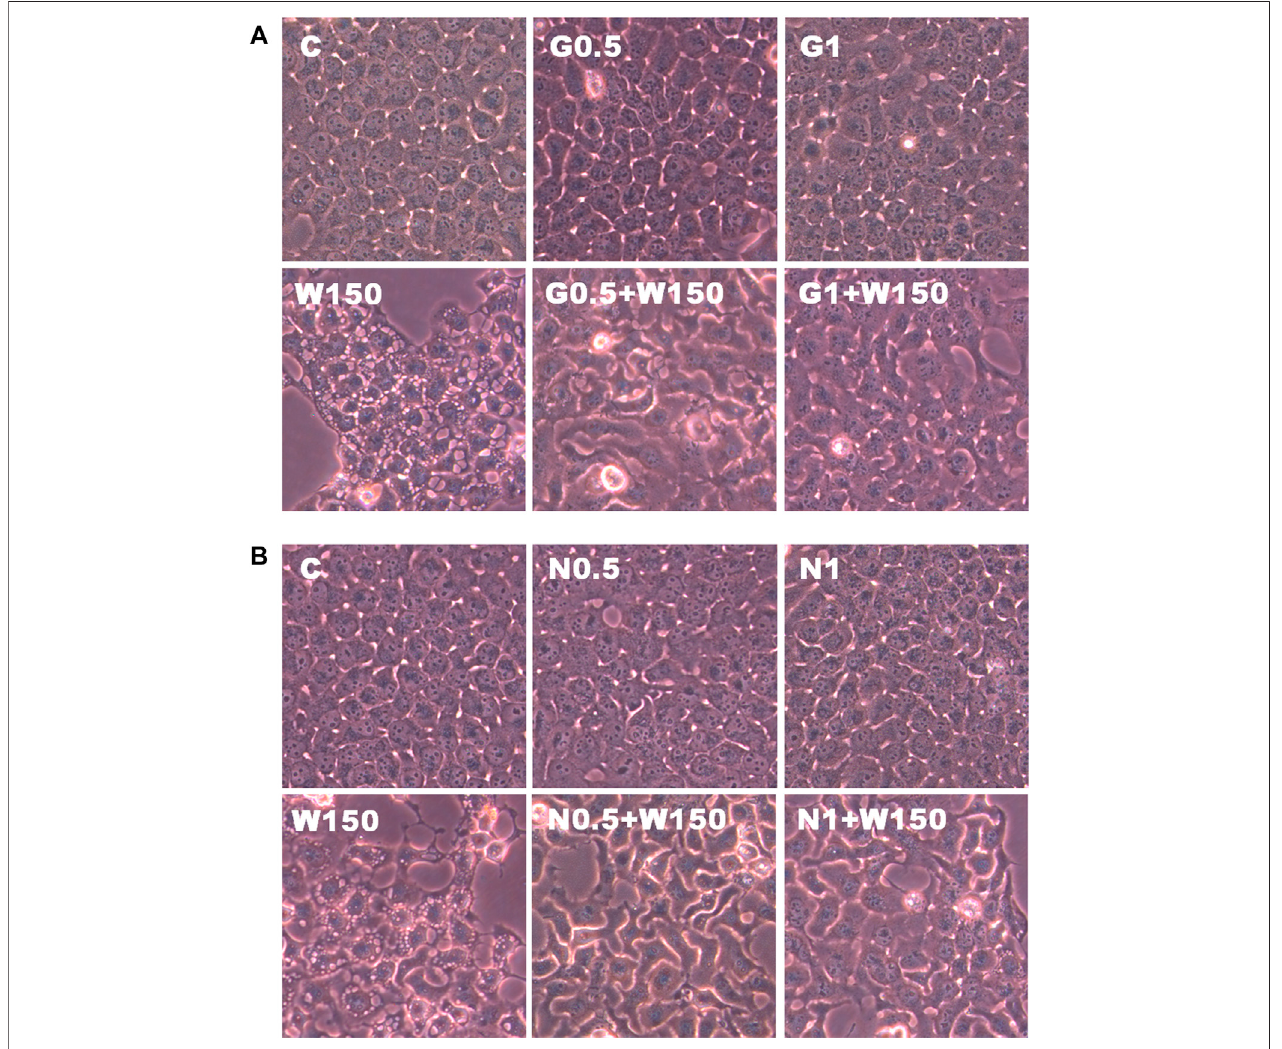
FIGURE 8 | Effects of GSH or NAC on WGM extracts-induced changes in cell morphology of Hep3B cells. (A) Cells were pretreated with 0.5 or 1 mM GSH (G0.5 and G1) for 1 h and then 150 μ g/ml WGM extracts (W150) for 24 h. (B) Cells were pretreated with 0.5 or 1 mM NAC (N0.5 and N1) for 1 h and then 150 μ g/ml WGM extracts (W150) for 24 h. After treatment, the cells were fast taken a phase-contrast image (150X). Results are representative of three independent experiments.